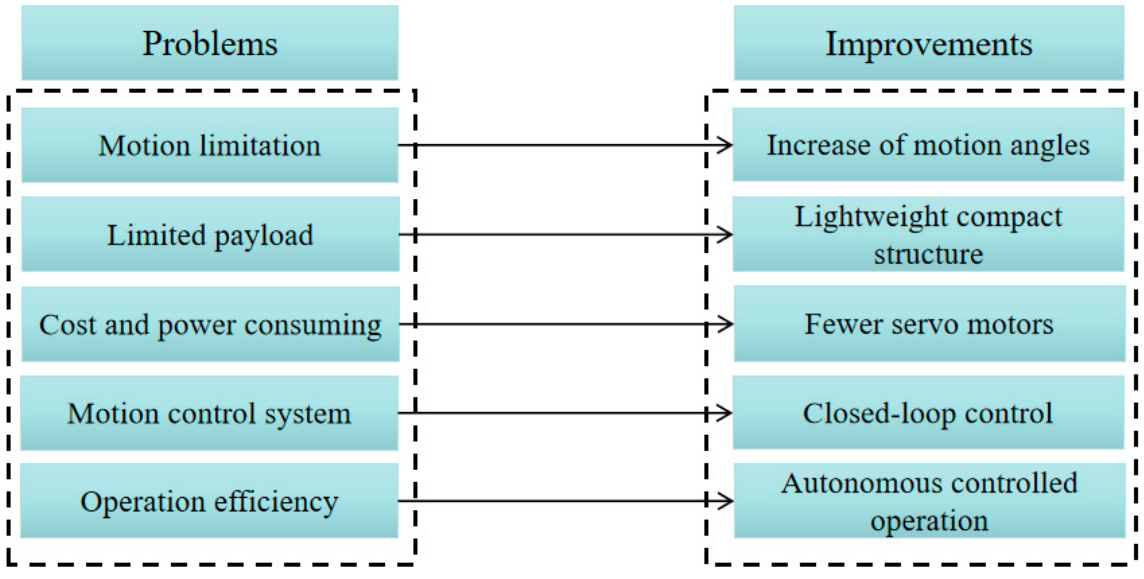
Figure 14. Problems and improvements for a new design of LARMbot torso.